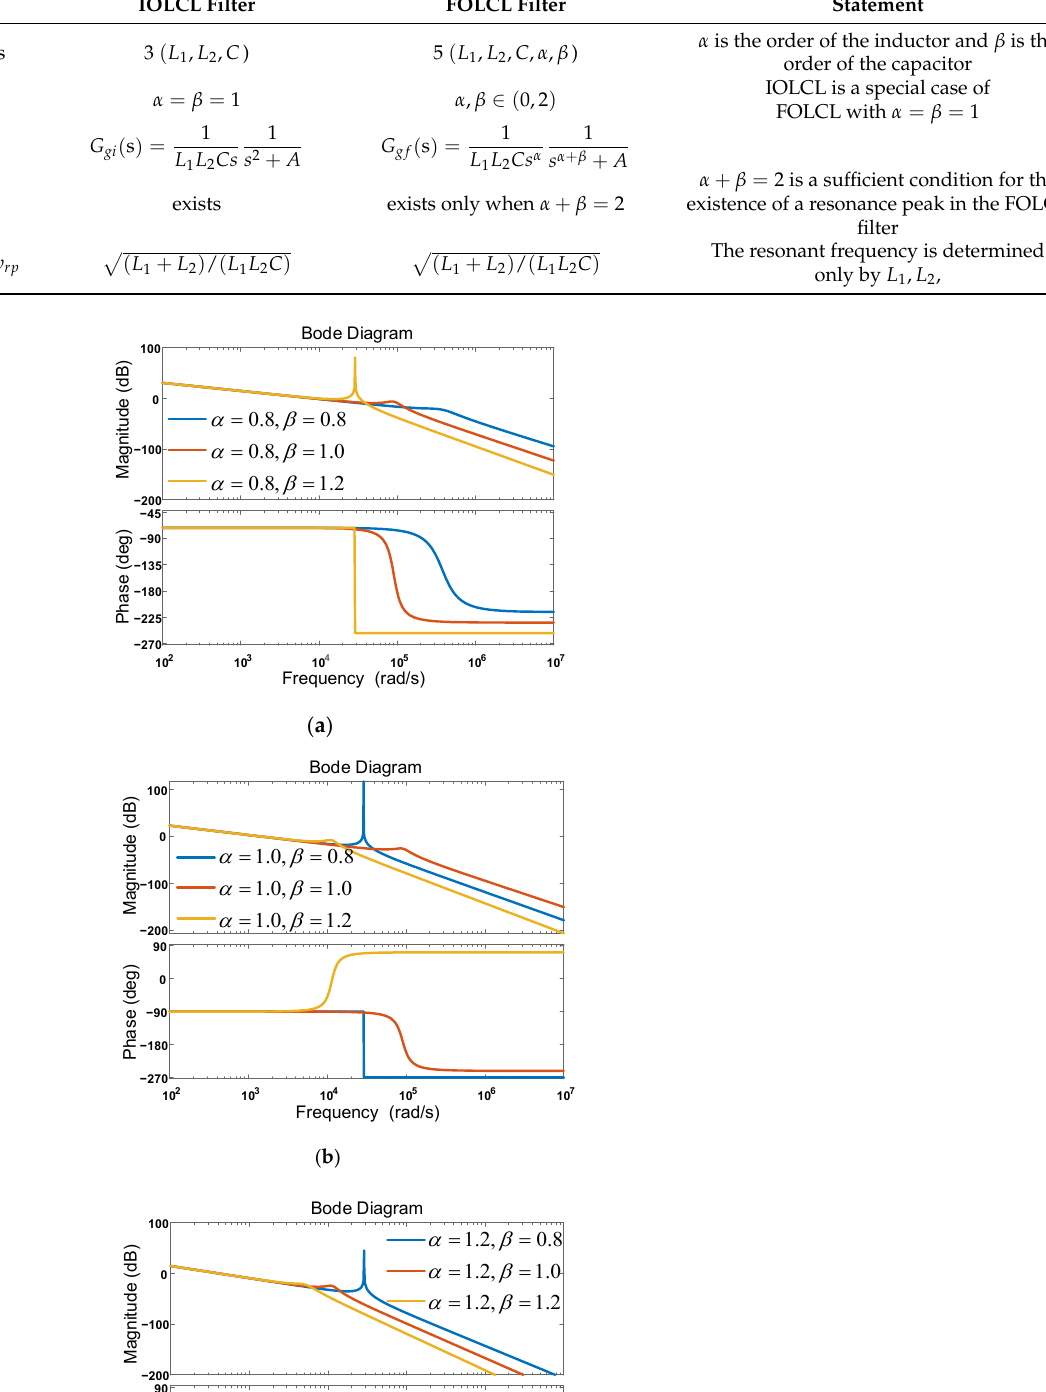
Table 1. Characteristics comparison of IOLCL and FOLCL filters.